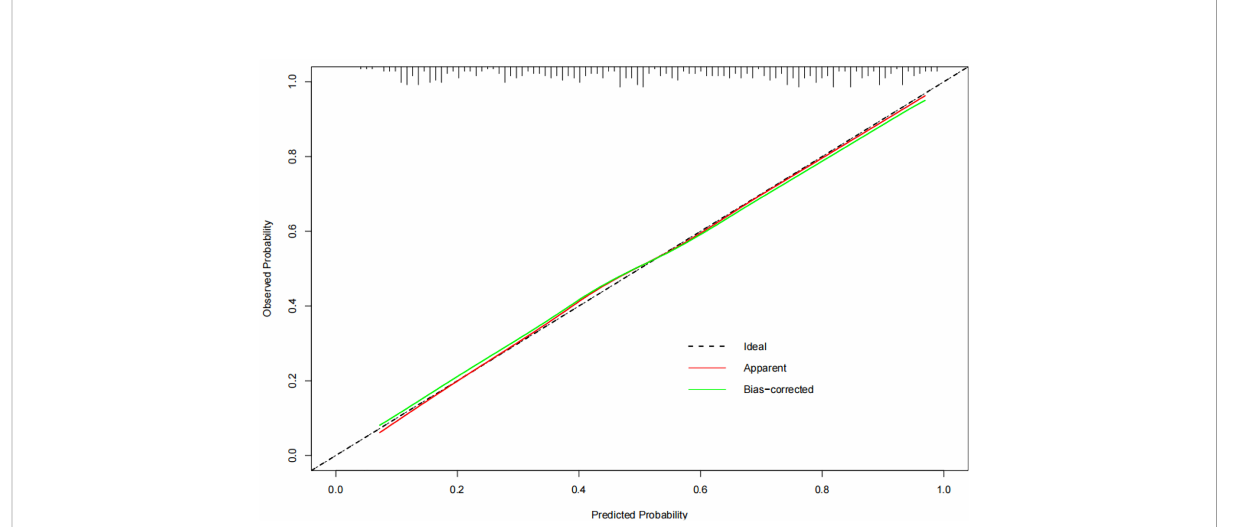
FIGURE 7 The calibration curve of the nomogram. The calibration curve shows whether the nomogram has goodness of fi t. where the grey diagonal line is the ideal prediction. The closer to the diagonal line, the better the performance